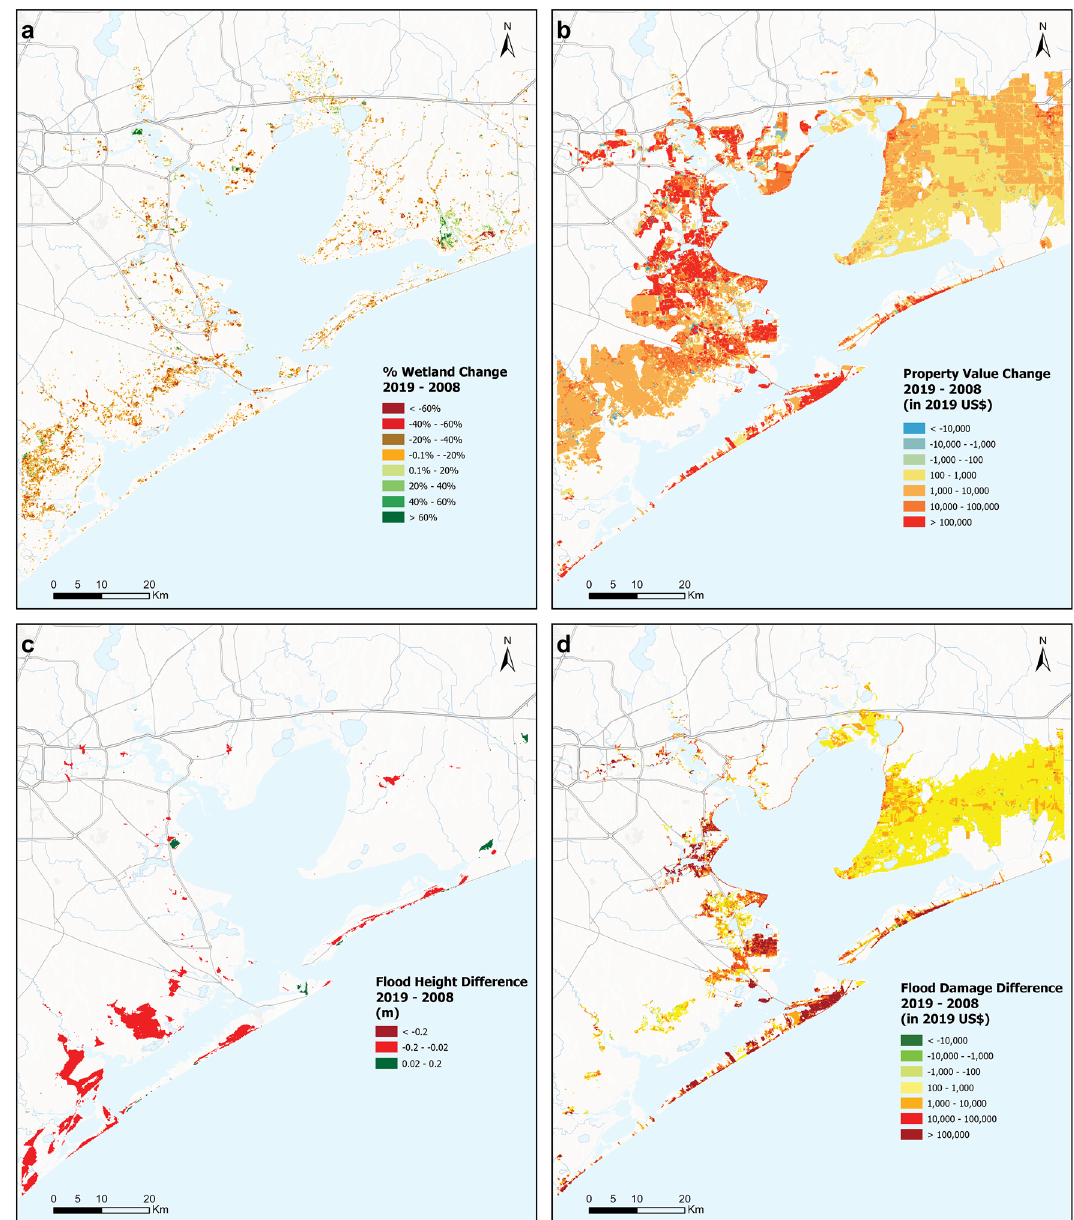
Figure 3. ( a ) Change in wetland cover between 2008 and 2019 in Galveston Bay: orange and green areas denote loss and gain in wetland cover, respectively, and light-yellow areas denote wetlands that did not change. ( b ) Property value change between 2008 and 2019, including increases in real estate prices in red, decreases in blue and no change in yellow ( c ) Difference in peak flood heights (i.e. difference between flood elevations and topographical elevations with respect to the MSL datum) between with 2019 “Present-Day Hurricane Ike” and 2008 Baseline scenarios, ( d ) Difference in economic storm surge damages between 2019 “Present-Day Hurricane Ike” and 2008 Baseline